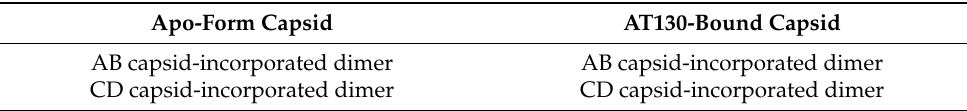
Table 1. The four MD simulation systems analyzed in this study. Apo-Form